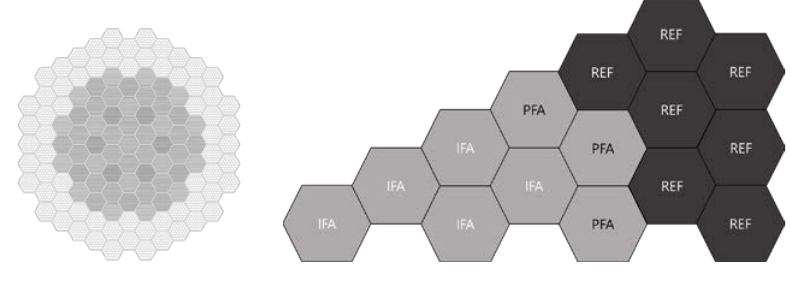
Figure 3. Two-dimensional Color-set Problem (IFA: interior FA, PFA: peripheral FA, REF: